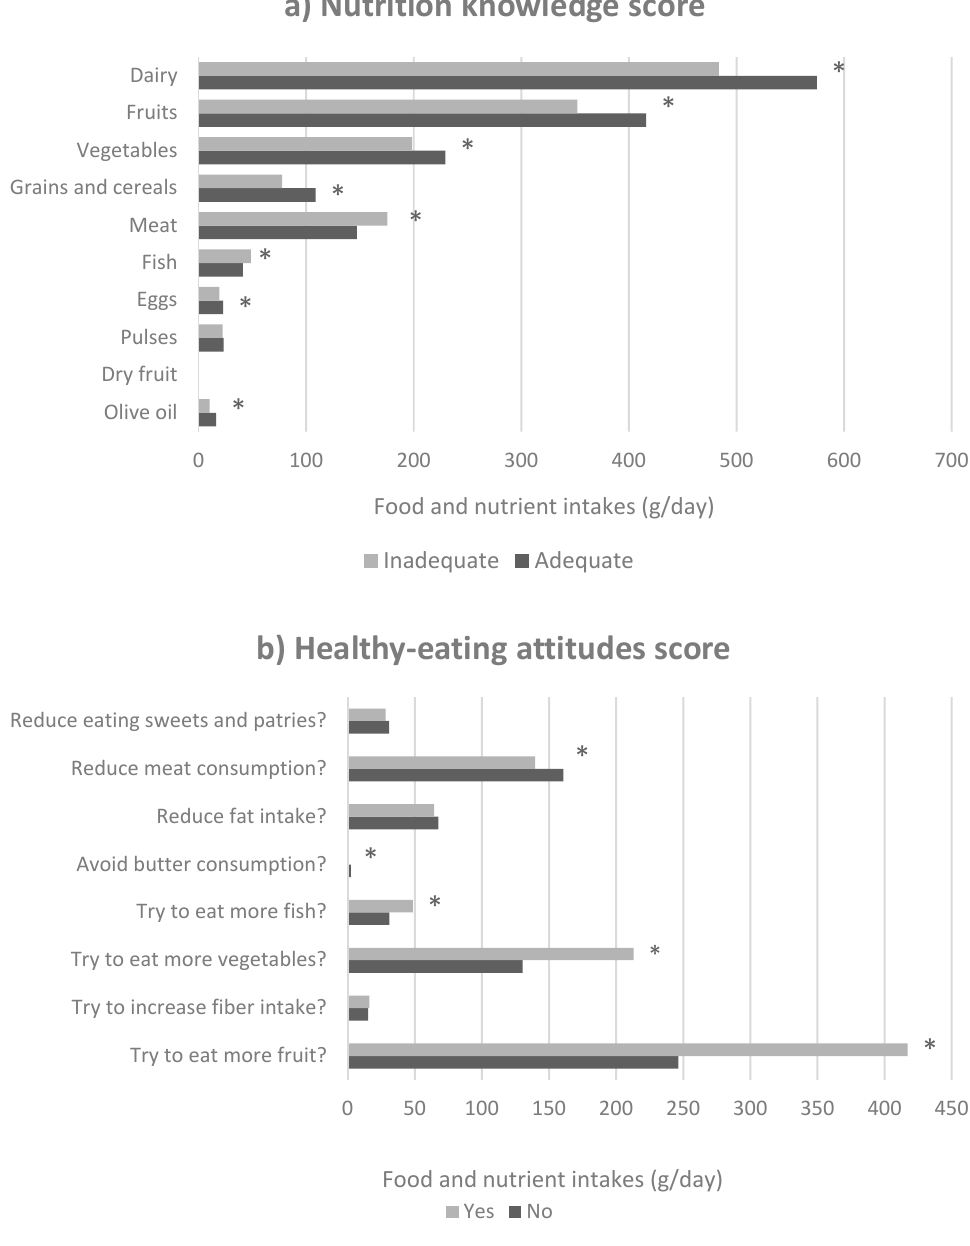
Figure 2. Mean food group consumption according to the positive answer in the nutrition knowledge score ( a ) and healthy-eating attitudes score ( b ); * p < 0.05.